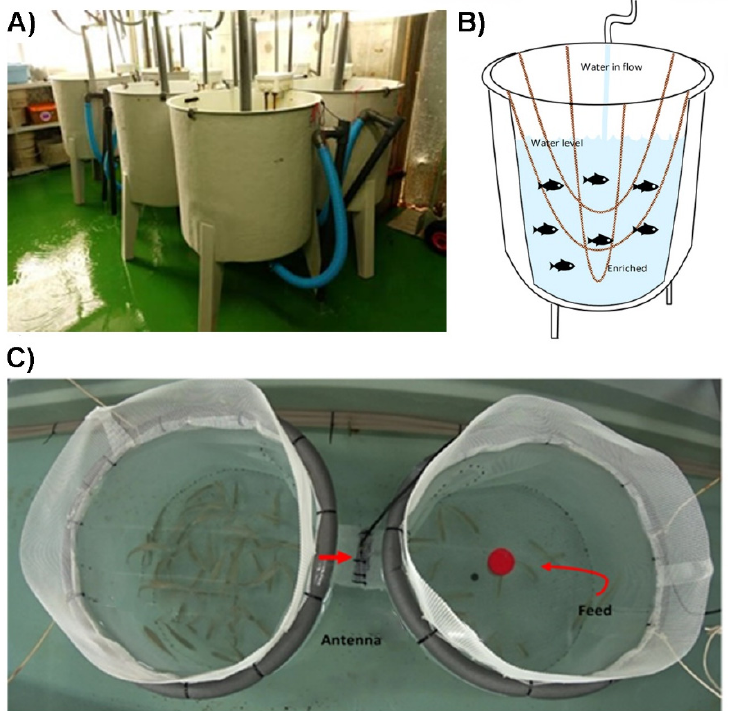
Figure 1. Experimental settings: ( A ) six circular tanks (150 L each) in a flow-through system; ( B ) schematic representation of the suspended ropes used as structural enrichment; ( C ) top view of the group-based risk-taking test used in the present study.